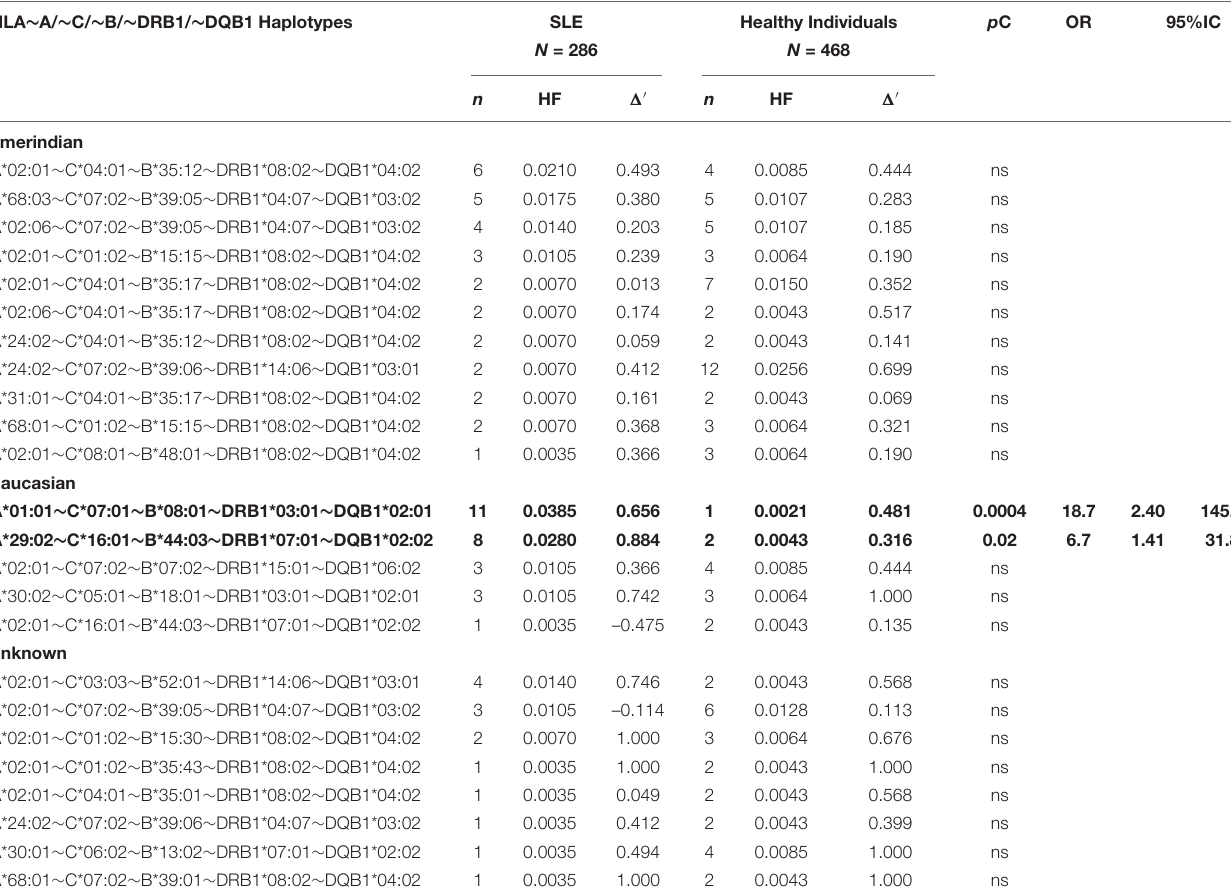
TABLE 7 | Frequencies of HLA ∼ A/ ∼ C/ ∼ B/ ∼ DRB1/ ∼ DQB1 haplotypes in SLE patients and healthy individuals. HLA ∼ A/ ∼ C/ ∼ B/ ∼ DRB1/ ∼ DQB1